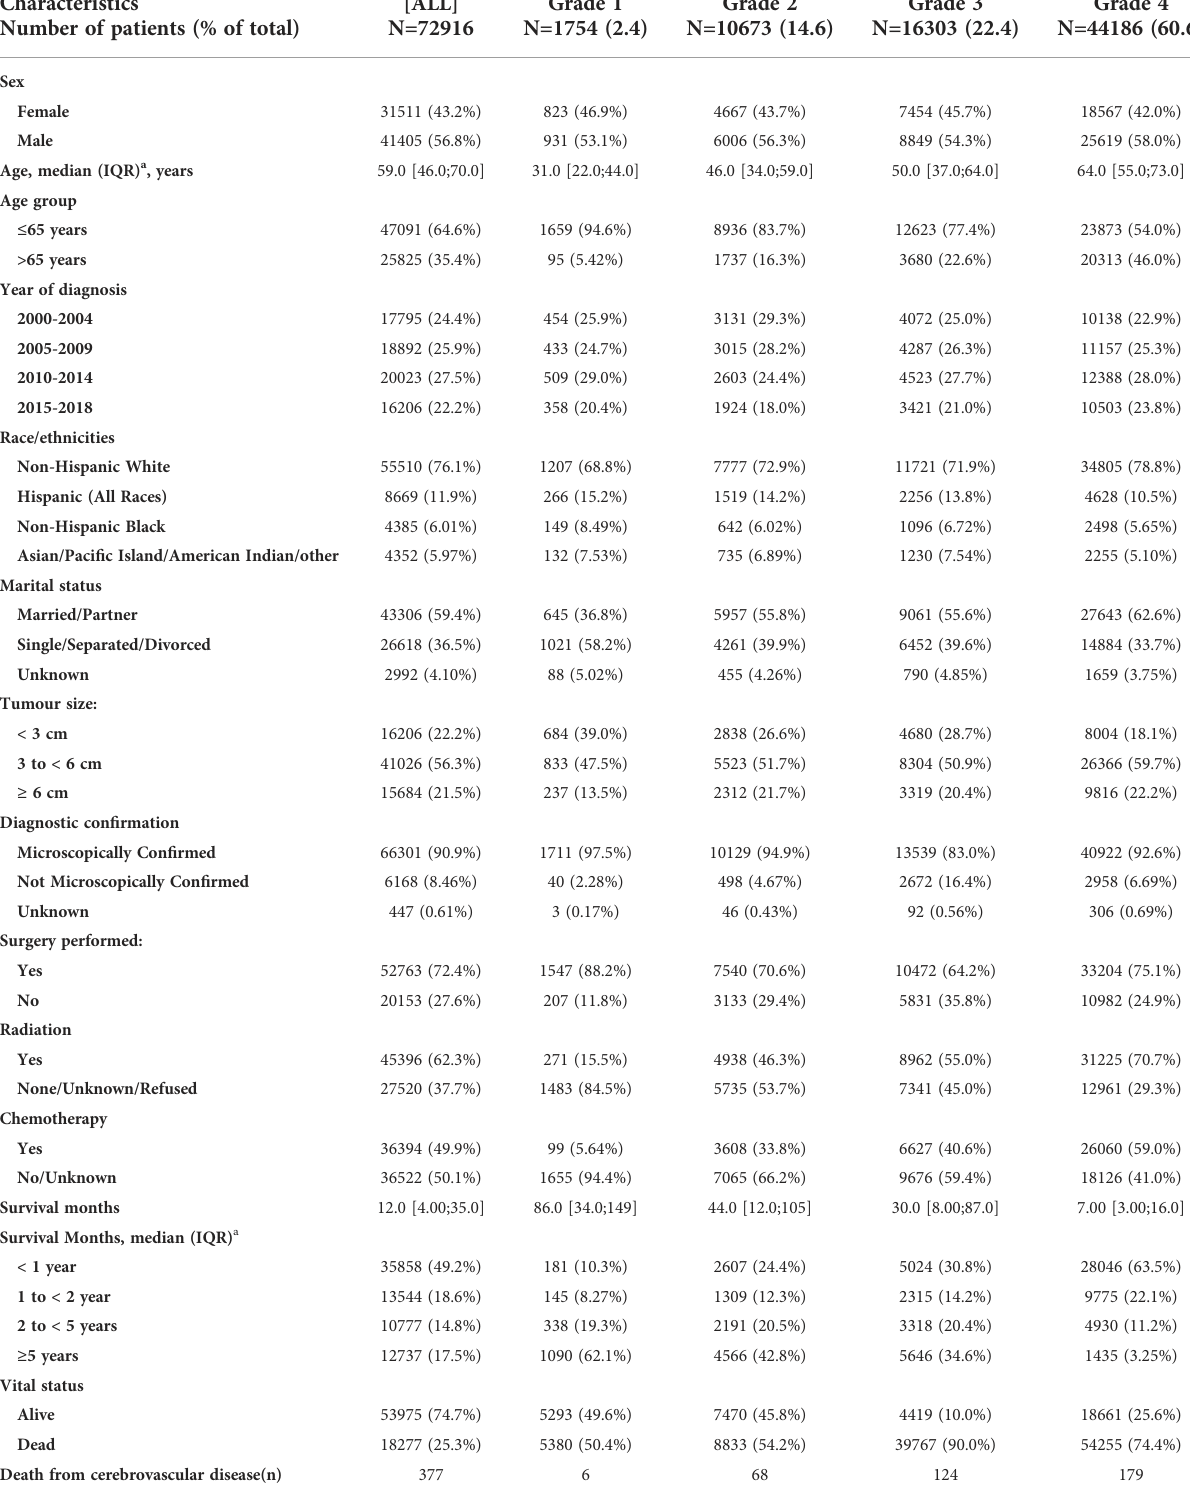
TABLE 1 Characteristics of the study cohort SEER